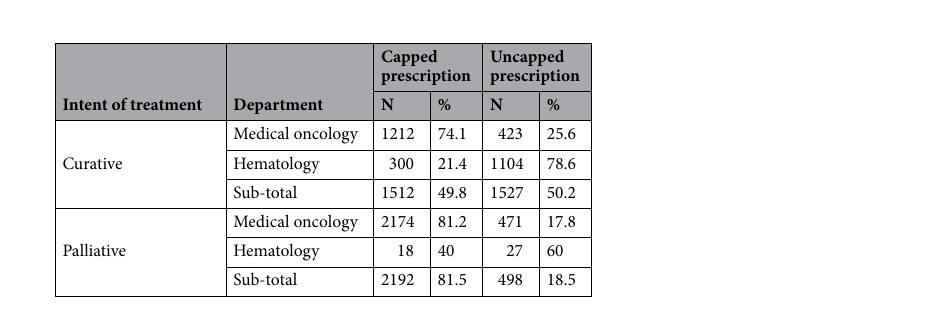
Table 5. Therapeutic approach and chemotherapy dose limitation.